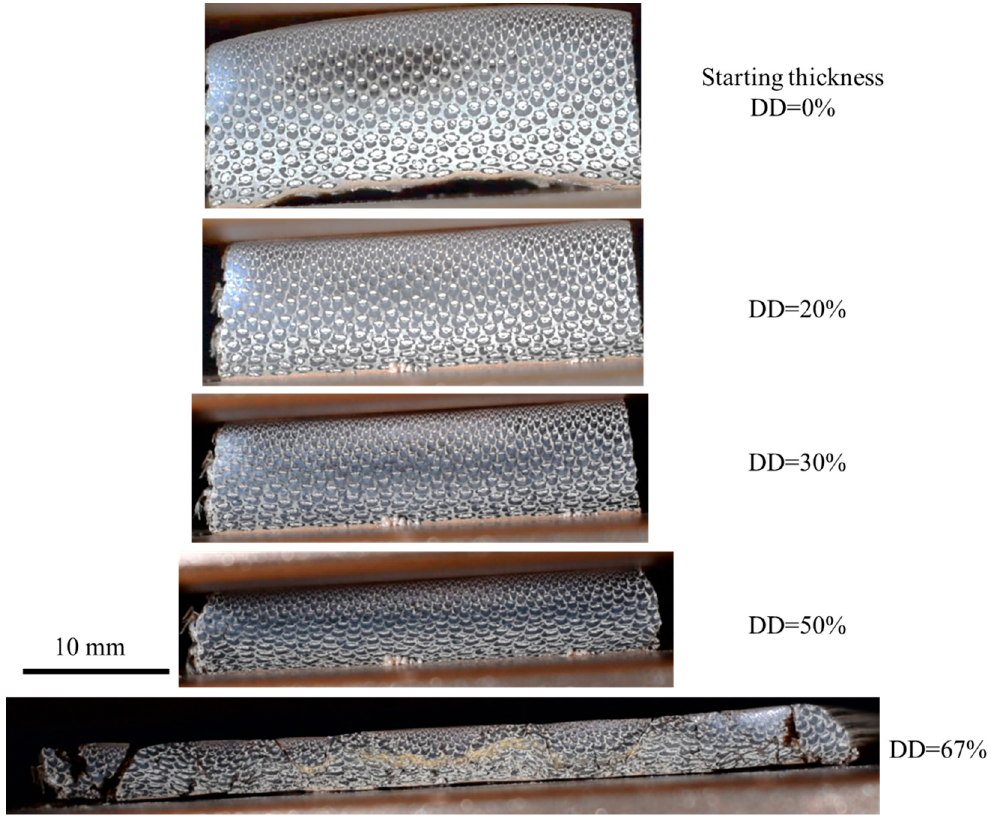
Figure 15. Cross sections of D.Asper strips densified at 160 °C.